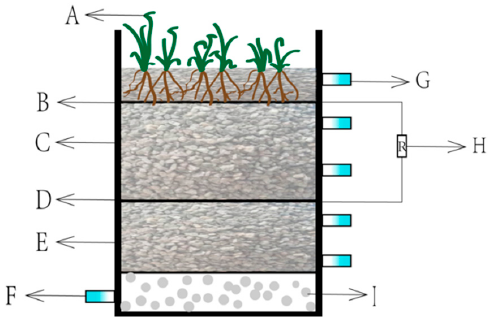
Figure 15. Diagram of the experimental device. A: wetland plant; B: activated carbon; C: upper packing; D: activated carbon; E: lower packing; F: water inlet; G: delivery port; H: resistance; I: gravel.